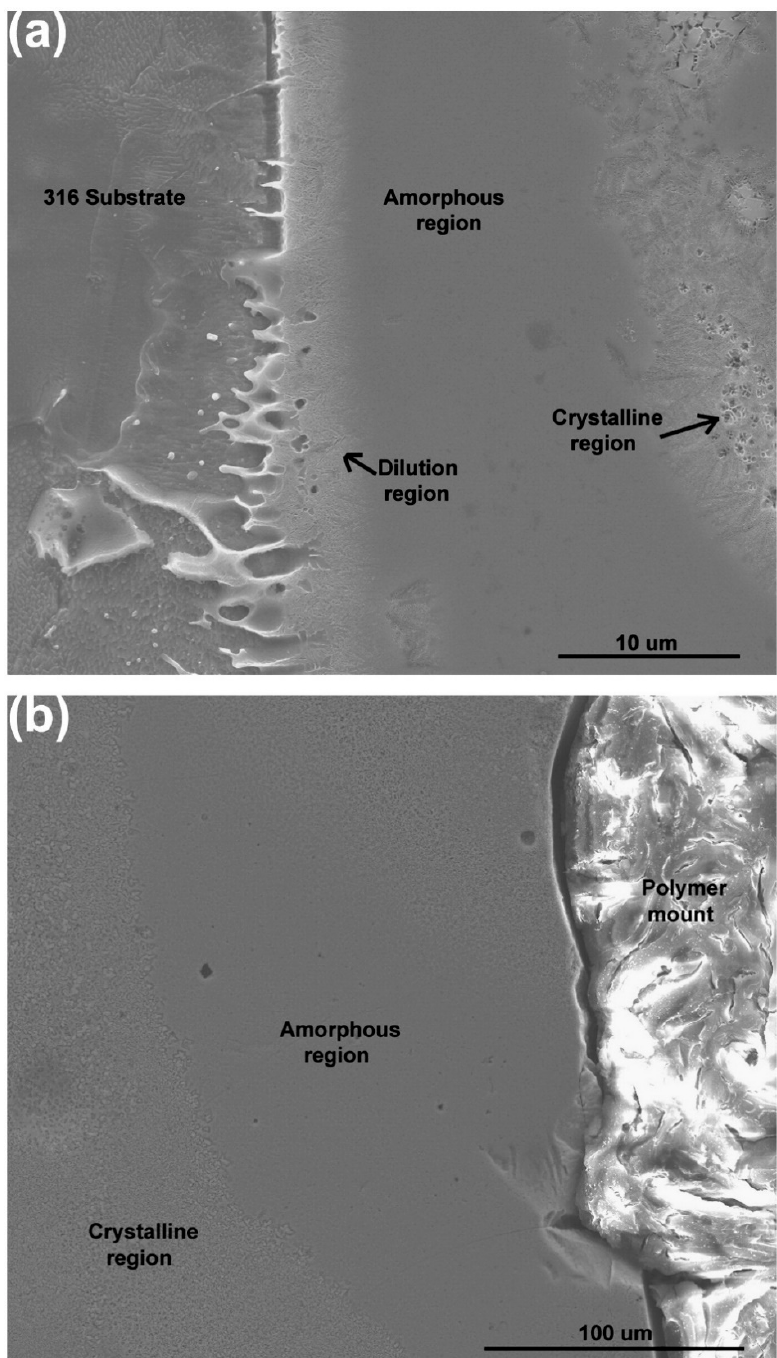
Figure 18. Cross-sectional SEM micrographs of 3D-printed NSSHS7574 alloy ( a ) demonstrating exceptional interfacial bonding between substrate and the produced alloy ( b ) the microstructure at the top region of the bulk specimen (reprinted with the permission from [80], Elsevier, 2010).